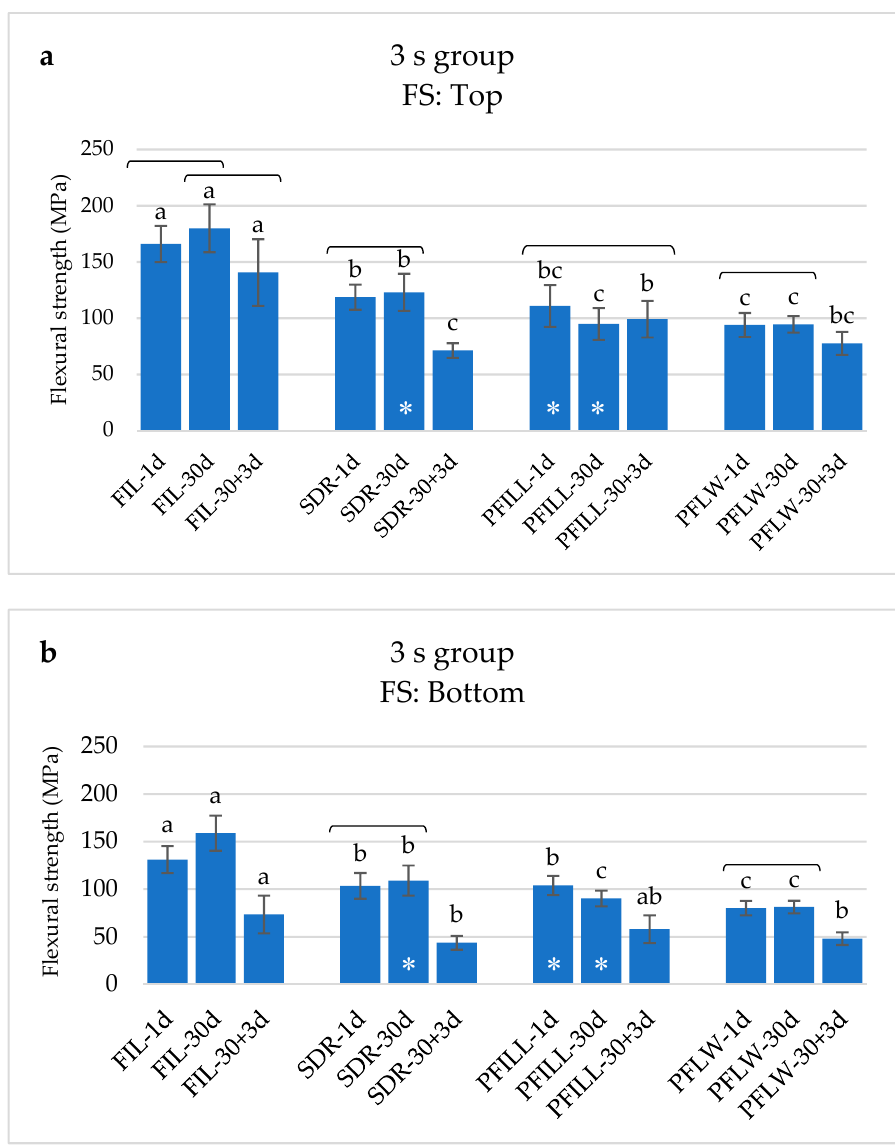
Figure 5. Flexural strength (mean values ± 1 standard deviation) for materials polymerized with 3 s protocol: ( a ) top specimens, ( b ) bottom specimens. The same letters show statistically homogeneous groups for a particular time point. Brackets indicate statistically homogeneous groups for each material. Asterisk denotes no statistically significant differences between top ( a ) and bottom specimens ( b ) of the same material and time point ( p < 0.05).